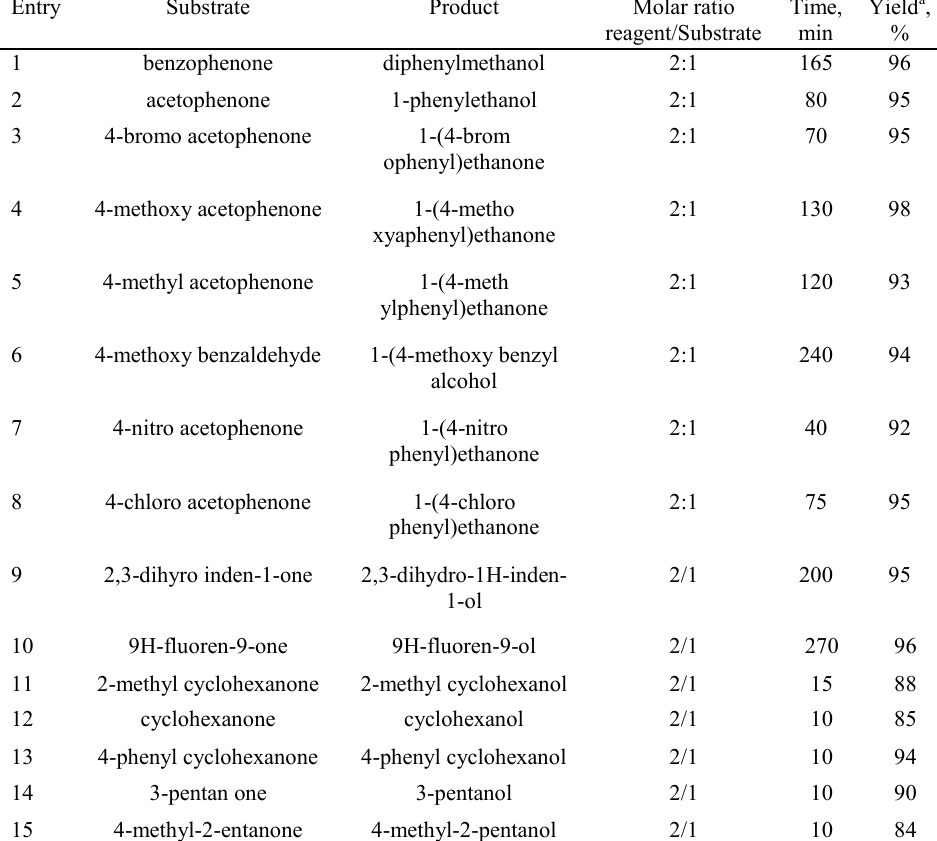
Table 4. Reduction of Ketones with [Zn(BH4)2(nic)] in CH3CN at Room